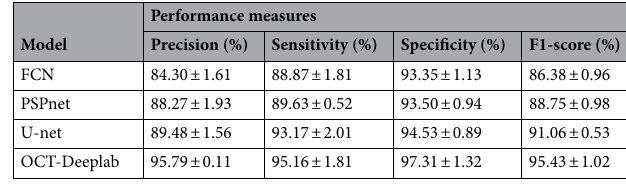
Table 3. Performance comparison between different segmentation